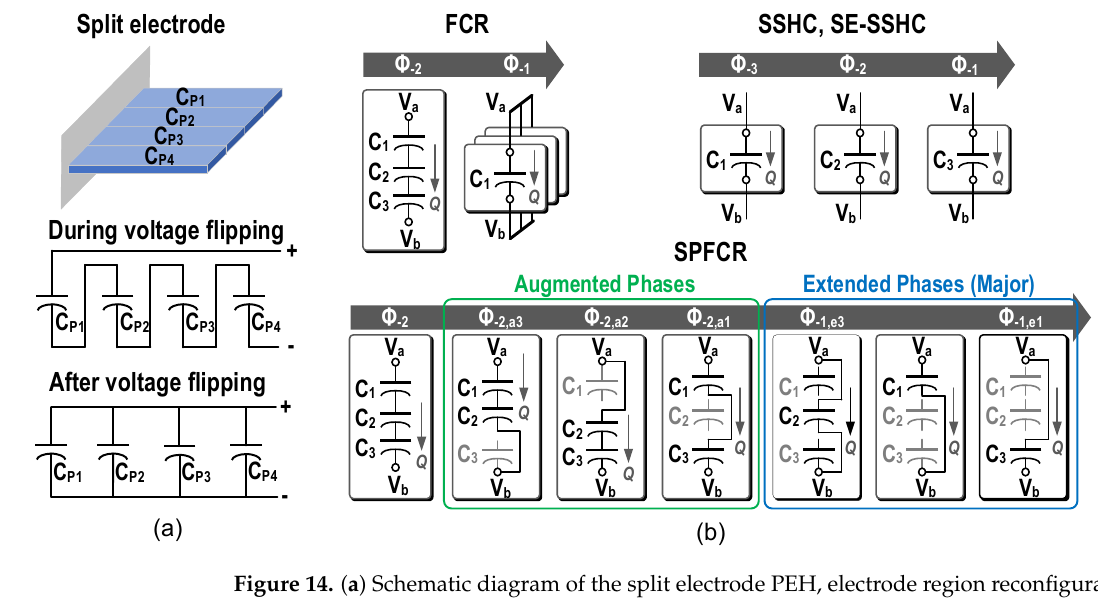
Figure 14. ( a ) Schematic diagram of the split electrode PEH, electrode region reconfiguration during and after the voltage flipping process, ( b ) capacitor reconfiguration examples using three flying capacitors for the FCR, the SSHC, the SE-SSHC, and the SPFCR.